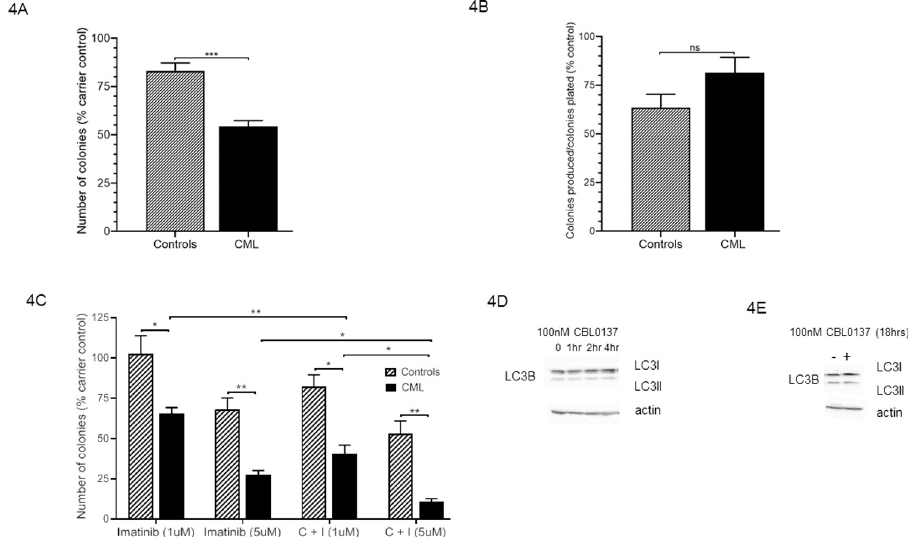
Fig 4. CBL0137 selectively reduces the clonogenic activity of CD34+ cells isolated from CML patients. Colony forming assays were performed in the presence or absence of 100nM CBL0137 with CD34 + cells enriched from control and CML patients in methylcellulose complete media (R&D systems) supplemented with 2u/ml EPO with cells at a density of 3000cells/ml (Fig 4A). Colonies were counted at day 14 and are expressed as a percentage of carrier control (mean ± SEM, n = 6 for CML and n = 8 for healthy controls). The average number of colonies seen in carrier control was 71 ± 14 for CML and 49 ± 5 for healthy controls (mean ± SEM). Colonies produced after 7 days were resuspended and replated in methylcellulose (Fig 4B). The number of colonies was assessed following 14 days and the data expressed as a percentage of control in relation to the number of colonies produced as a fraction of the colonies plated (mean ± SEM, n = 6 for CML and n = 8 for healthy controls). The average number of colonies seen in carrier control was 47 ± 6 for CML and 74 ± 8 for healthy controls (mean ± SEM). Colony forming assays were performed in the presence of 100nM CBL0137 with either 1 μ M or 5 μ M Imatinib with CD34 + cells enriched from control and CML patients (Fig 4C). Colonies were counted at day 14 and the results expressed as a percentage of carrier control (mean ± SEM, n = 3). The average number of colonies seen in carrier control was 68 ± 10 for CML and 75 ± 12 for healthy controls (mean ± SEM). The results of a t-test results are represented by; ns–not significant, � < 0.05, �� < 0.01, ��� < 0.001. Western blot analysis of LC3B expression in K562 cell lysates following either a four hour time course (Fig 4D) or 18 hour treatment (Fig 4E) with 100nM